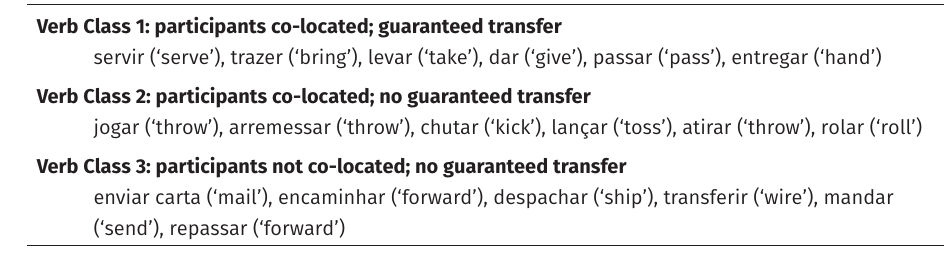
Table 1: Verb classes for experimental stimuli. Verb Class 1: participants co-located; guaranteed transfer servir (‘serve’), trazer (‘bring’), levar (‘take’), dar (‘give’), passar (‘pass’), entregar (‘hand’) Verb Class 2: participants co-located; no guaranteed transfer jogar (‘throw’), arremessar (‘throw’), chutar (‘kick’), lançar (‘toss’), atirar (‘throw’), rolar (‘roll’) Verb Class 3: participants not co-located; no guaranteed transfer enviar carta (‘mail’), encaminhar (‘forward’), despachar (‘ship’), transferir (‘wire’), mandar (‘send’), repassar